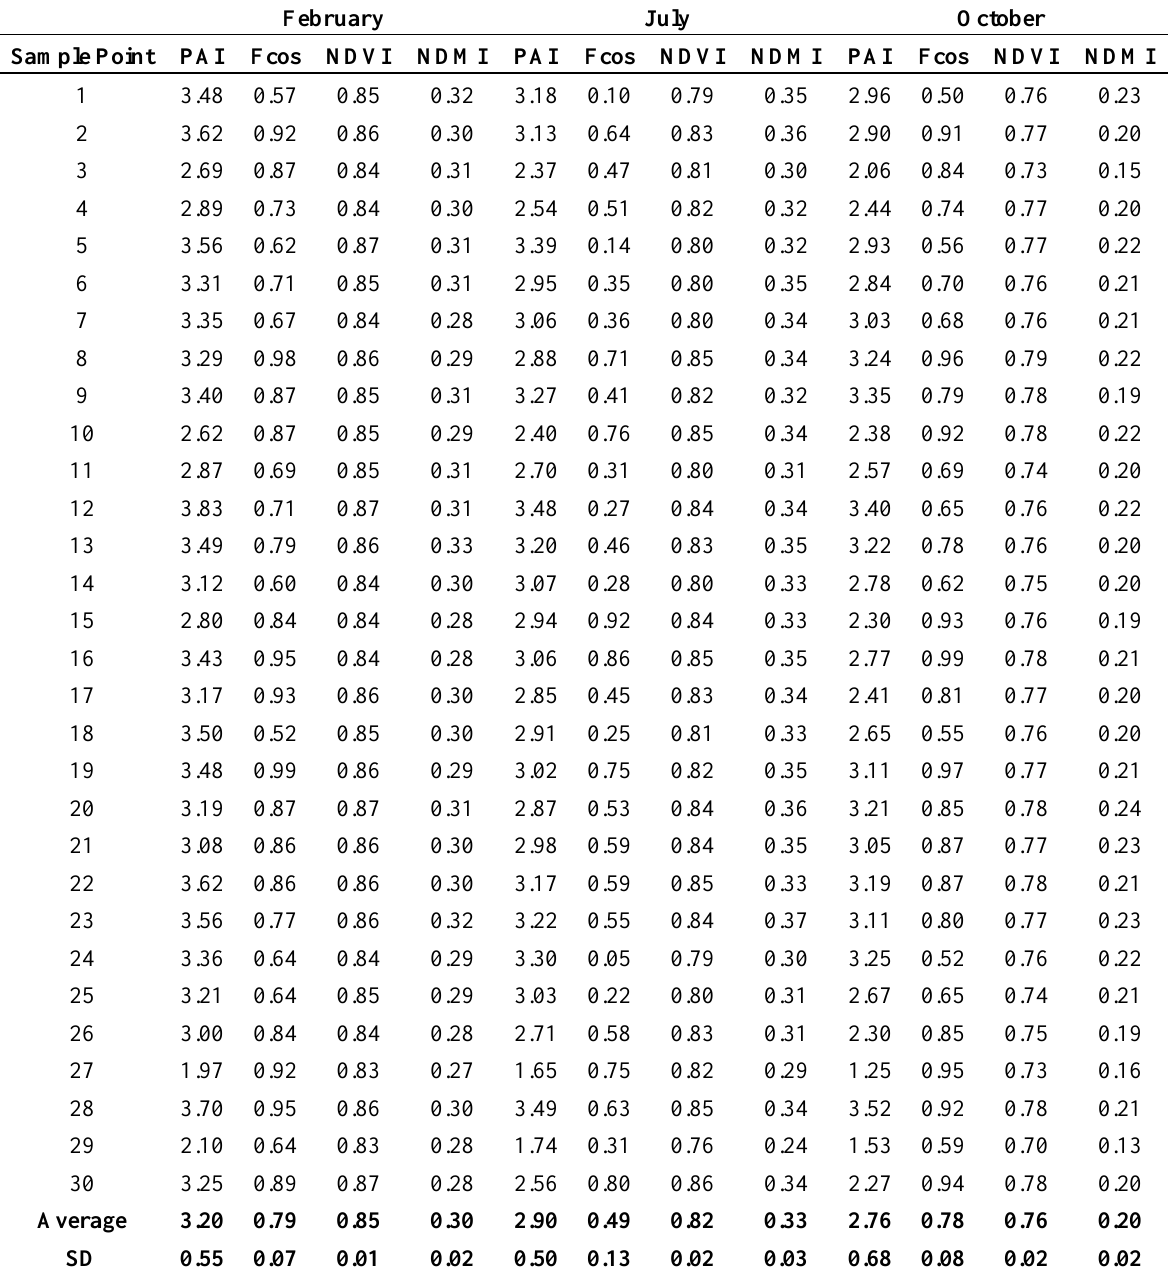
Table 3. PAI, cosine factor (Fco), NDVI and NDMI for each sample point and field